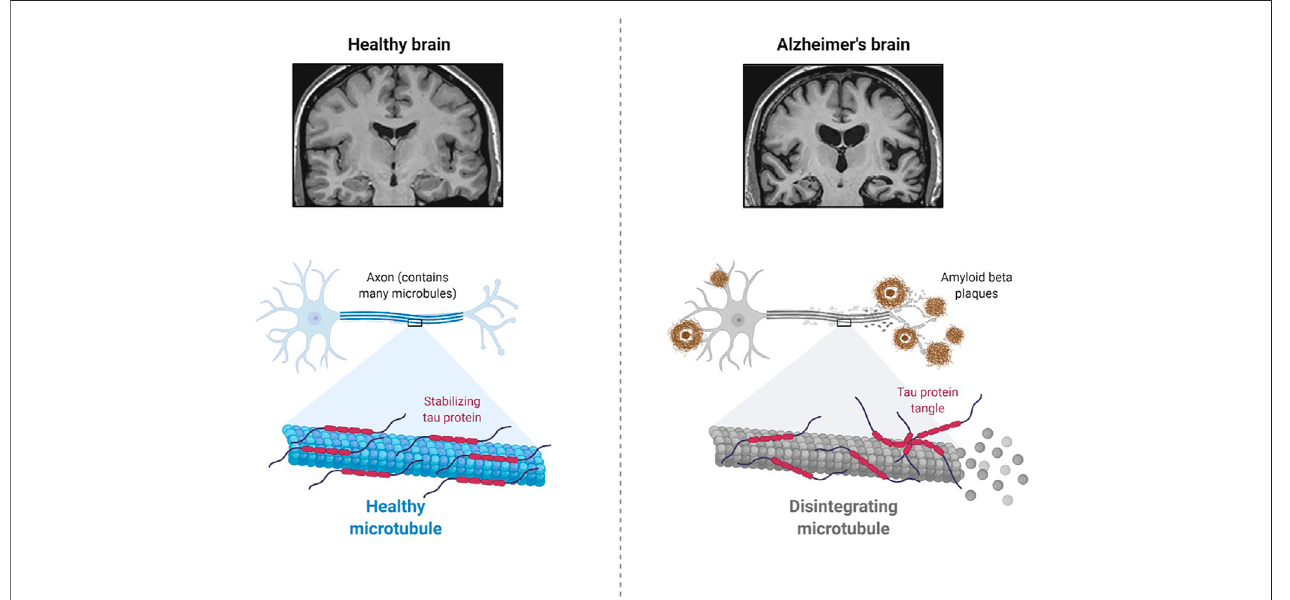
FIGURE 1 | Pathology of Alzheimer ’ s Disease (Created using Biorender.com).